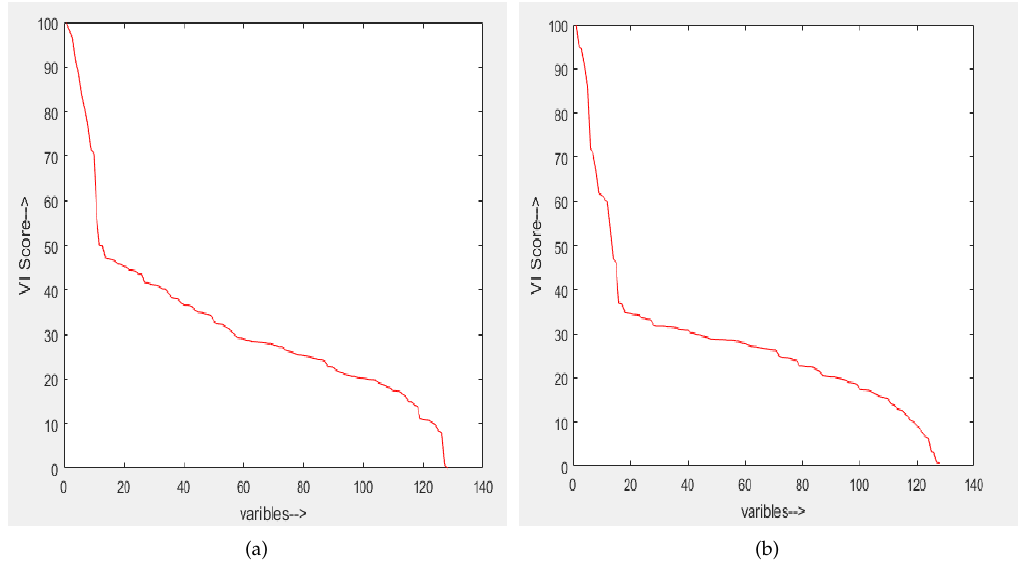
Figure 7. Ranking of variables (class-specific feature set) ( a ) Random forest, ( b ) Random uniform forest.